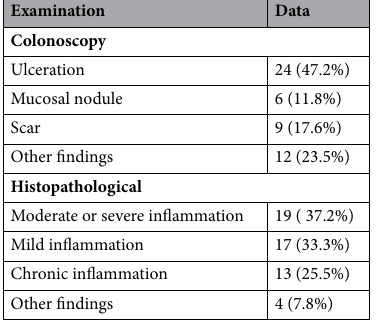
Table 2. Laboratory examination, colonoscopy and histopathological data of 51